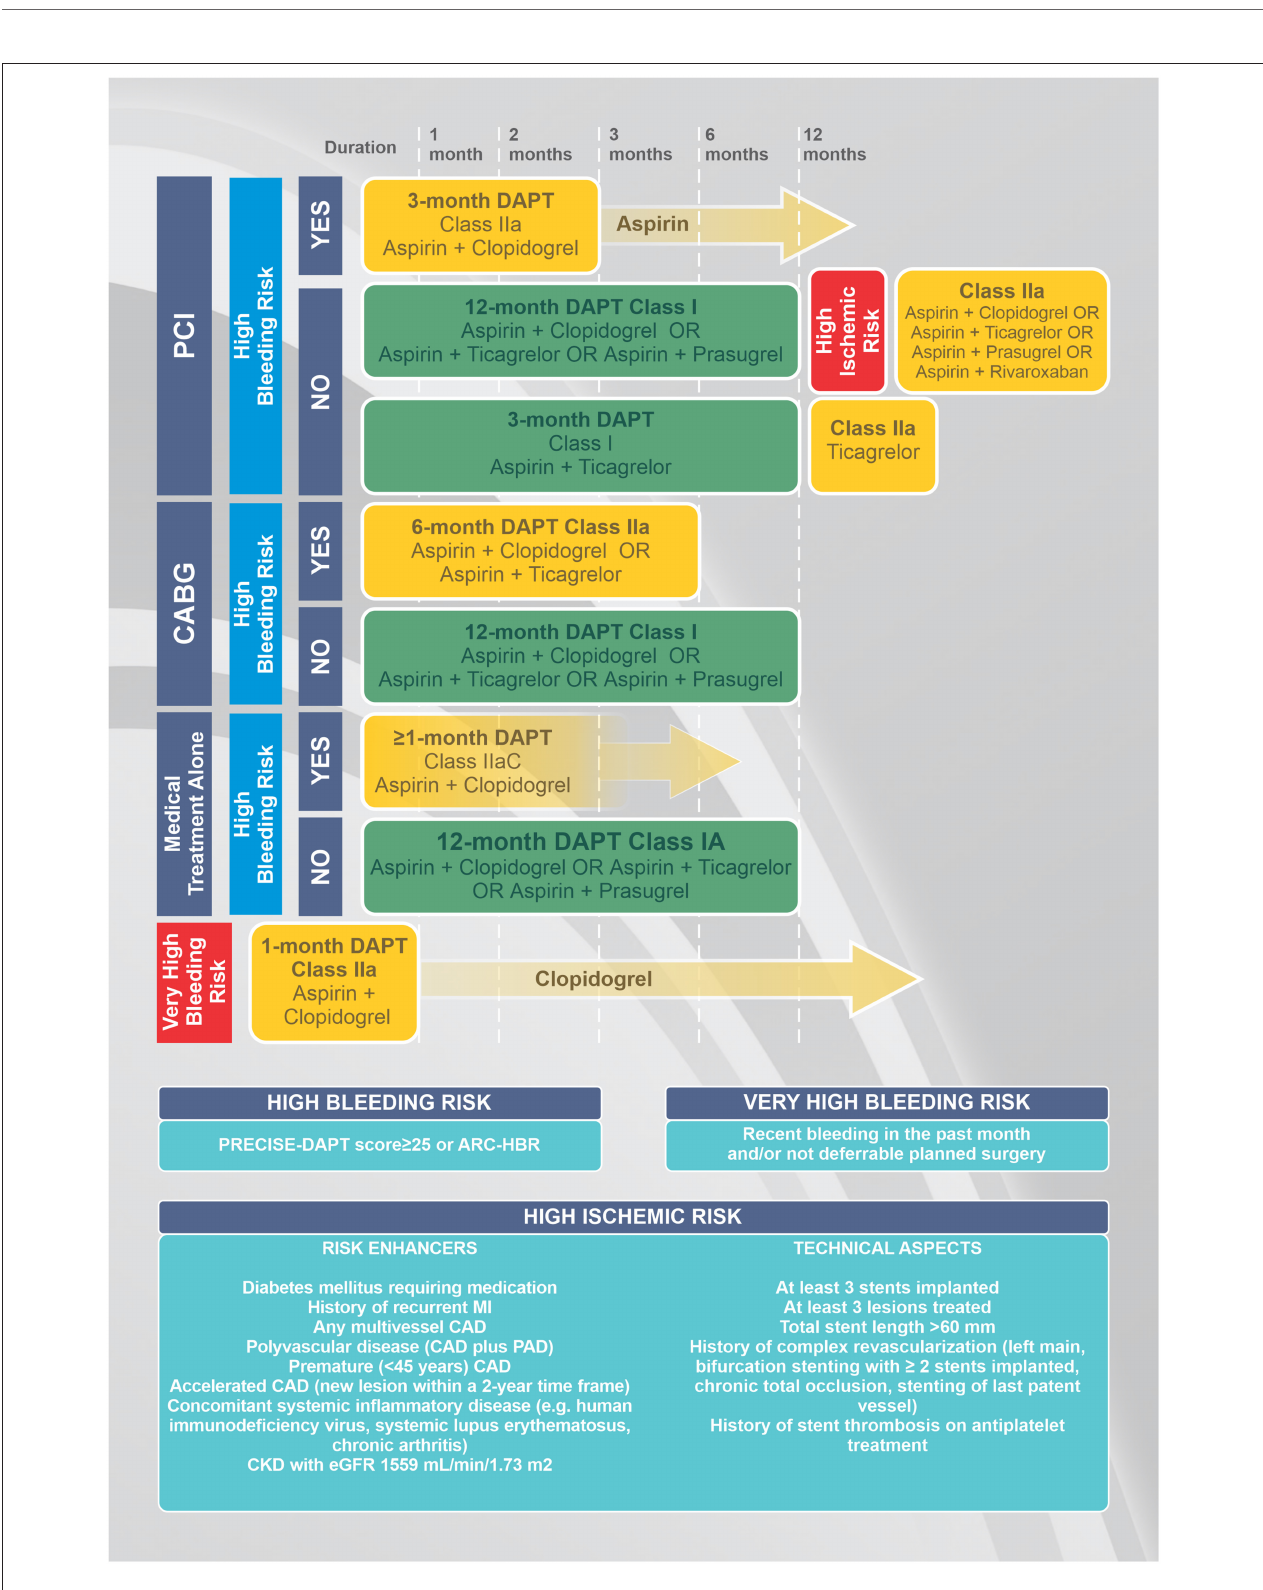
FIGURE 2 | Algorithm for a dual antiplatlet therapy (DAPT) scheme and timing in patients with acute coronary syndrome according to the treatment and bleeding risk. PCI, percutaneous coronary intervention; CABG, coronary artery bypass grafting surgery; ARC-HBR, Academic Research Consortium High Bleeding Risk; PRECISE-DAPT, PREdicting bleeding Complications In patients undergoing Stent implantation and subsEquent Dual Anti Platelet Therapy; CAD, coronary artery disease; PAD, peripheral artery disease. Modified from Valgimigli et al. (50), Costa et al. (60), Collet et al. (65).